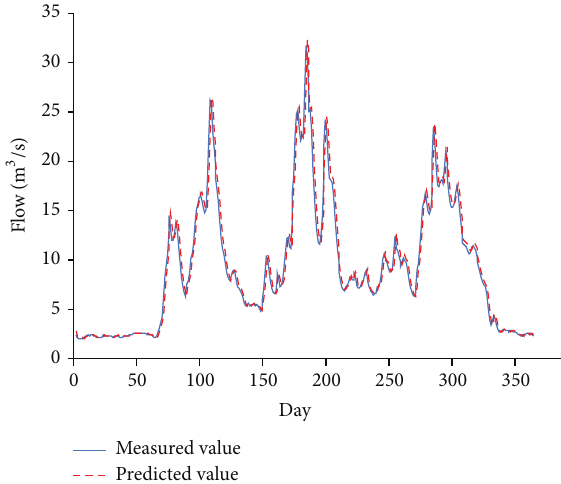
Figure 7: Daily runoff prediction for 2008 of Hei River using NNBR